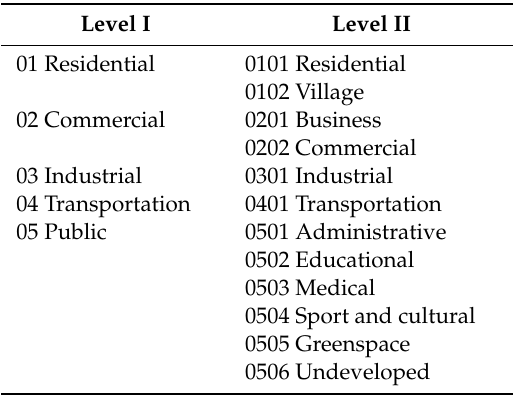
Table 2. Redefined classification system of